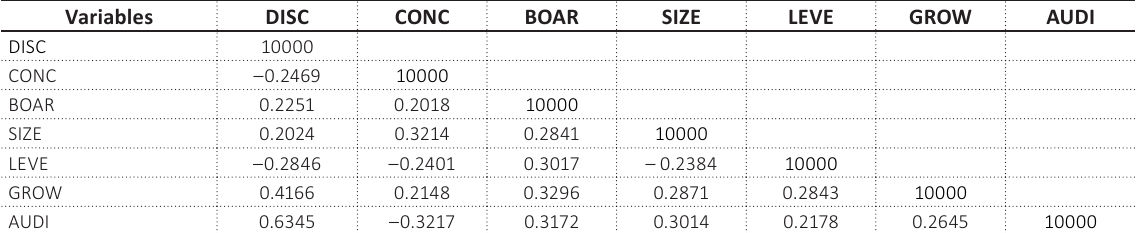
Table 3. Correlation matrix